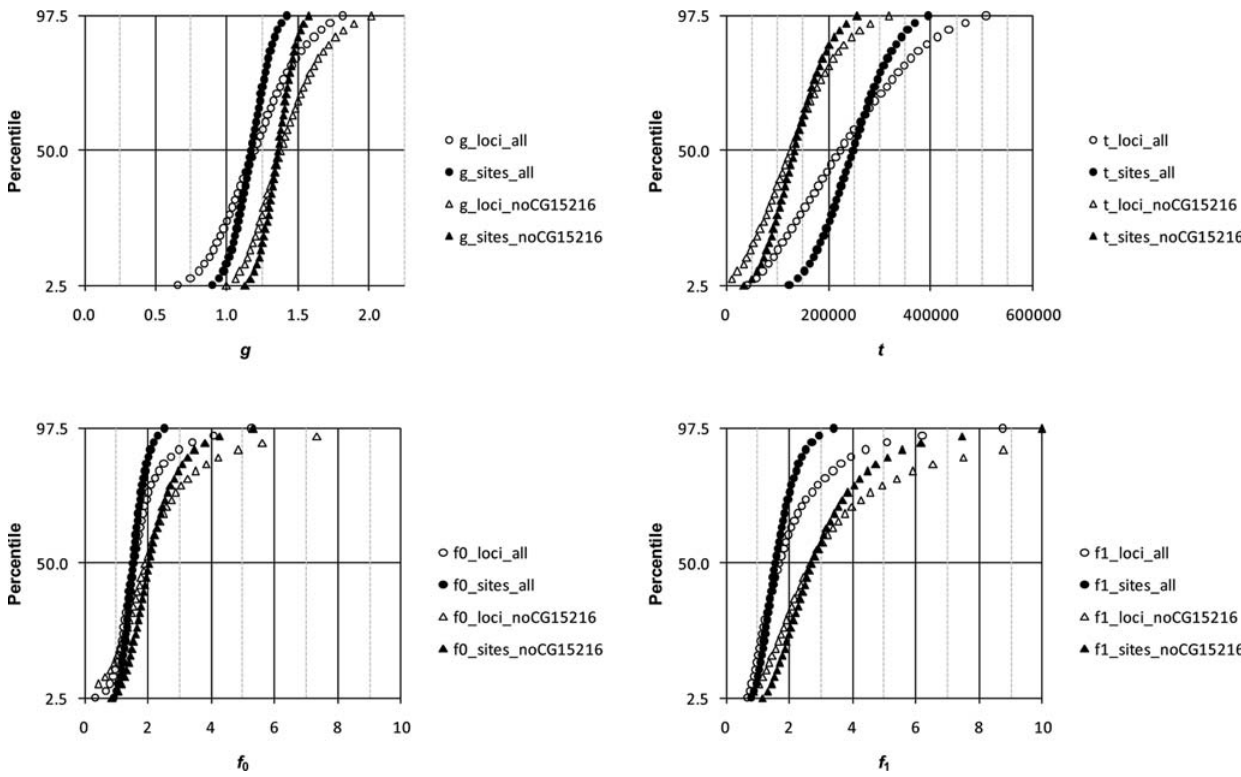
Figure 4. Distribution of parameters estimated from 10,000 bootstrapped data sets using the 4-parameter model for D.simulans and D.mauritiana . See Figure 1 for